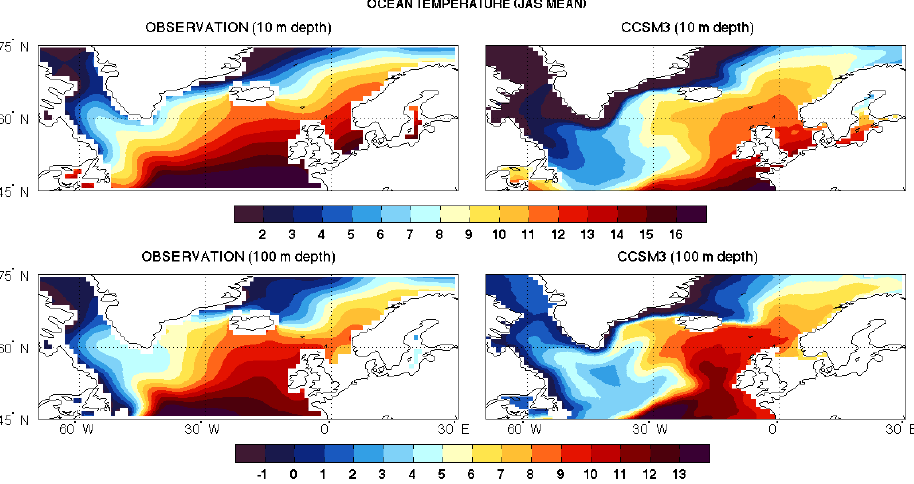
Fig. 4. Comparison of the mean January, February, and March temperature at 10m and 100m between CCSM3 and WOA98. NODC WOA98 data were provided by the NOAA/OAR/ESRL PSD, Boulder, Colorado, USA, from their Web site at http://www.esrl.noaa.gov/psd/.